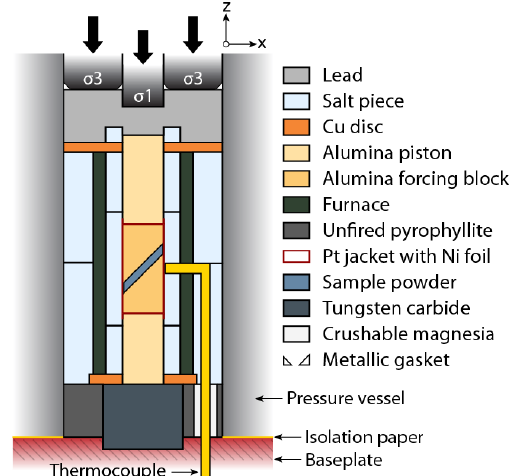
Figure 1. Drawing of the sample assembly in the Griggs-type ap-